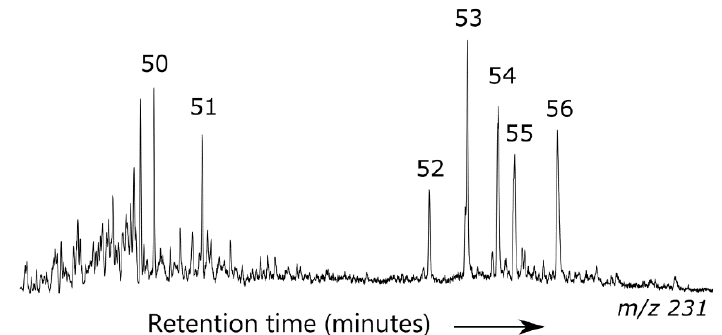
Figure 6. Representative m / z 231 ion chromatogram showing triaromatic steroids for the aromatic fraction of oil samples from the Block 17.